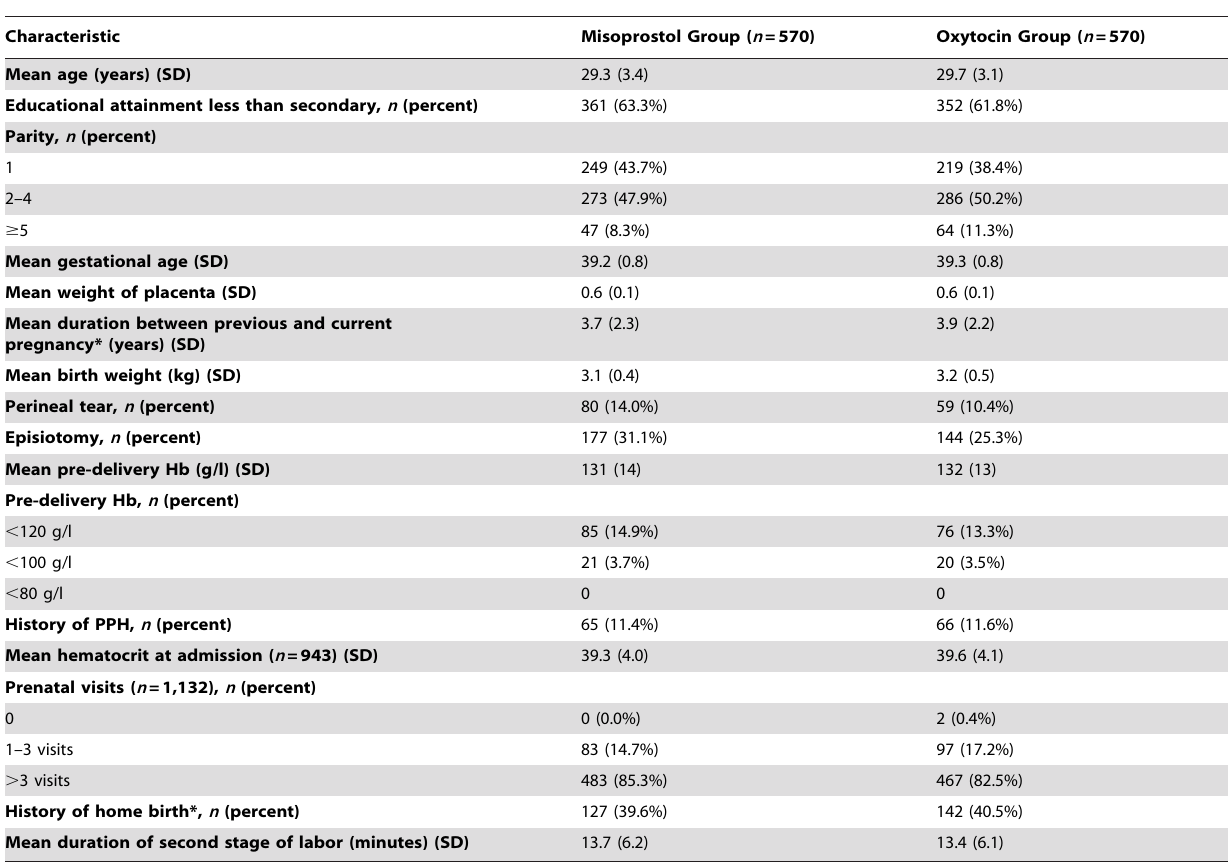
Table 1. Baseline demographic and clinical characteristics by treatment